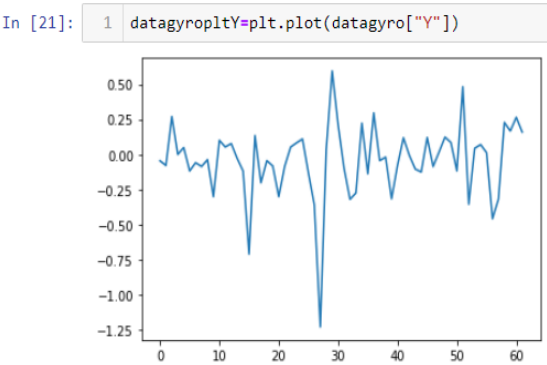
Figure 44. Gyroscope x -axis data.